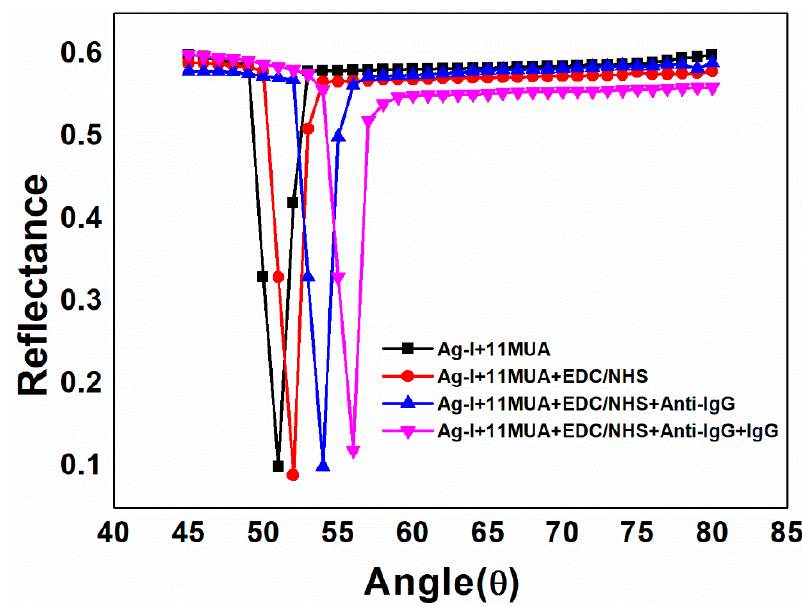
Figure 6. Reflectance vs. incident angle of stacked layers (test sensor: Ag-I test protein concentration: 0.1 mg/mL).